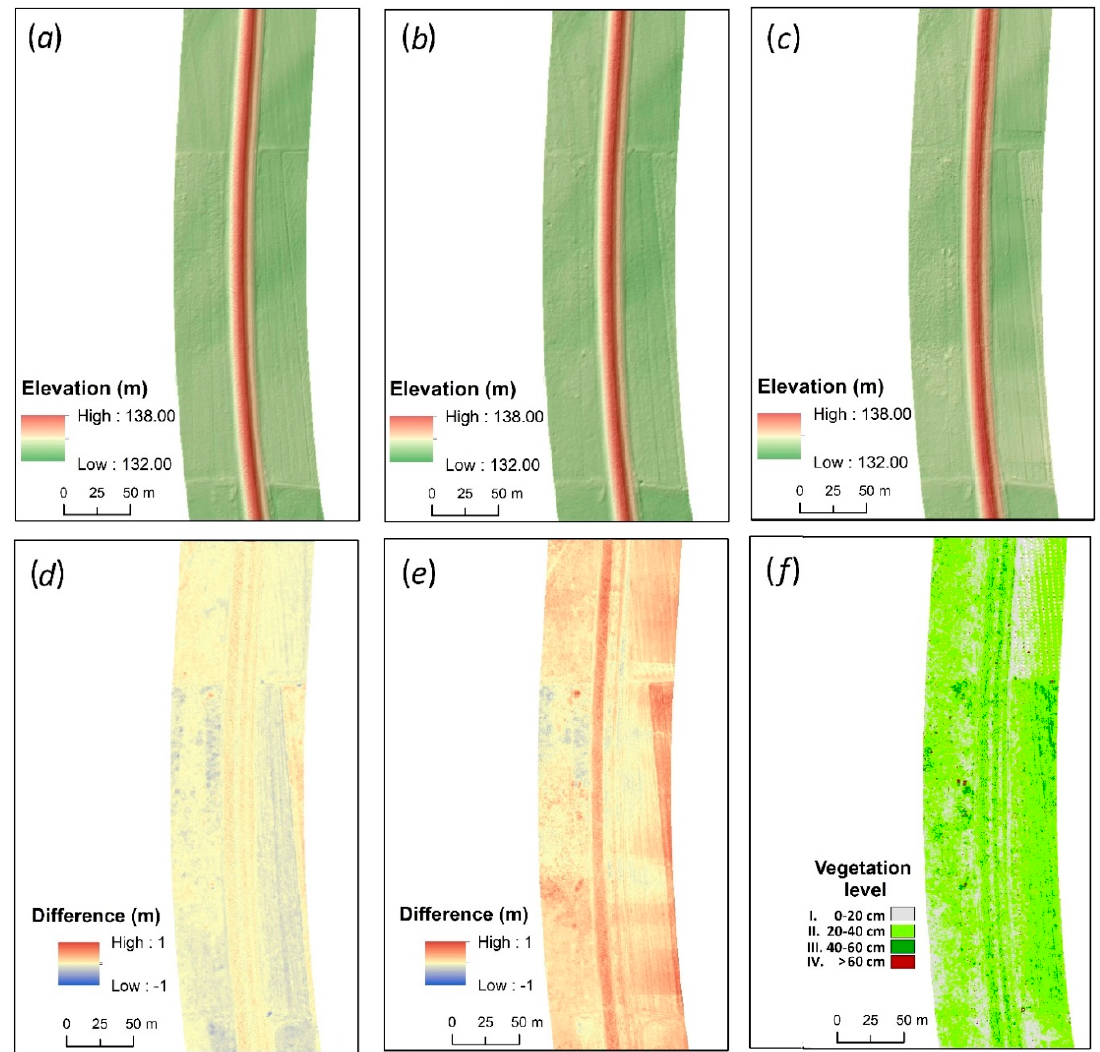
Figure 7. Fragment of the test area: created terrain models: DTM ALS ( a ), DTM ULS ( b ), DTM DIM ( c ), and their results in the subtraction of DTM diff_ULS ( d ), DTM diff_DIM ( e ), and vegetation height ( f ).